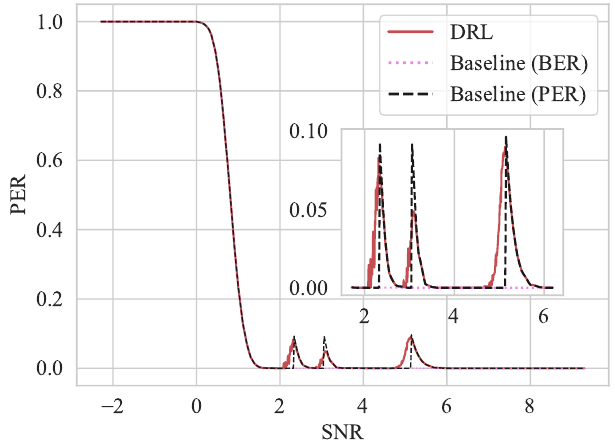
Figure 8. Comparison of PER of different methods at different